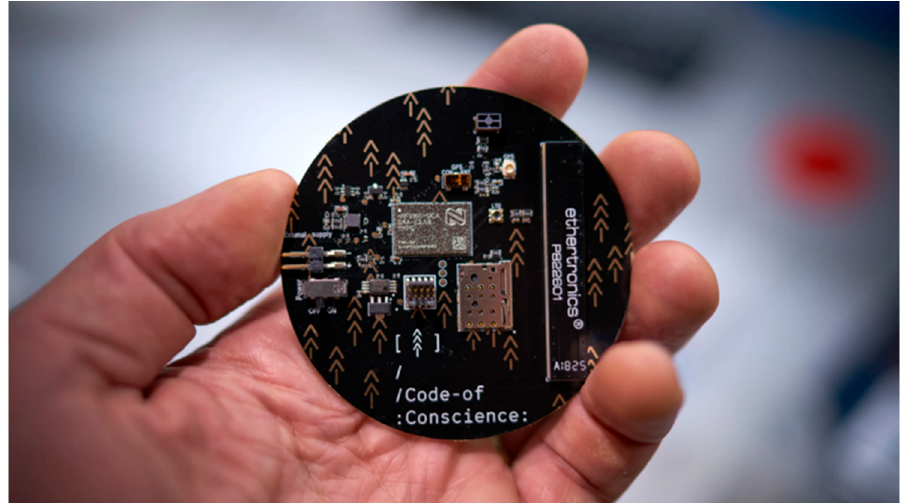
Figure 7. Detail of low-cost electronic hardware from Code of Conscience by AKQA.